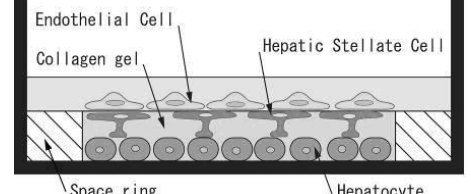
Fig. 1 Schematic diagram of the co-culture model, composed of hepatocytes, a collagen gel layer containing hepatic stellate cells, a spacer ring, and endothelial